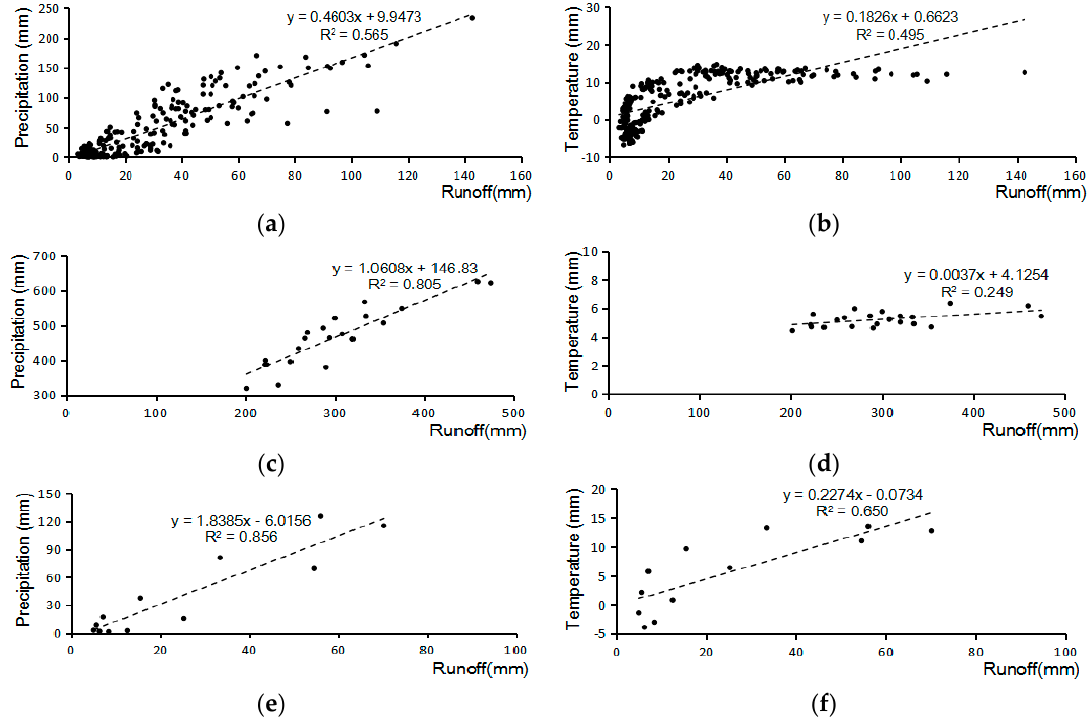
Figure 11. Correlation analysis between climate factors and runoff for 3 different time scales. ( a , b ) Mean monthly values; ( c , d ) Mean annual values; and, ( e , f ) Secular mean monthly values. Table 3. Correlation analysis between climate and runoff data at different scales.